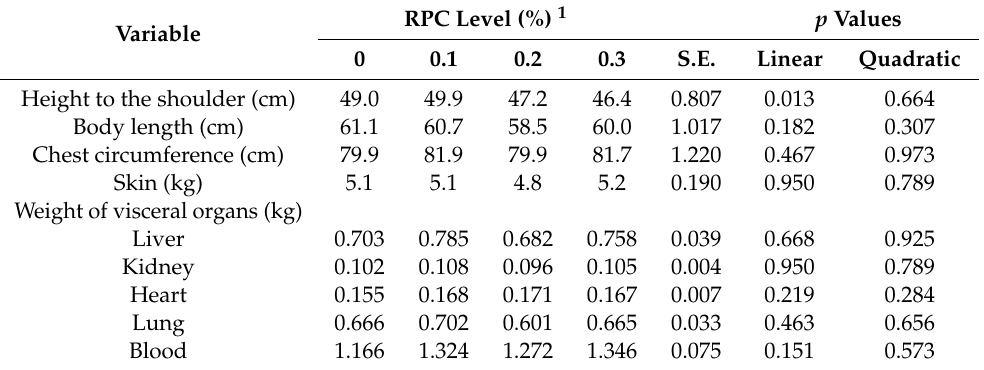
Table 3. Body measurements and visceral organ weights of lambs fed finishing diets containing various RPC levels.